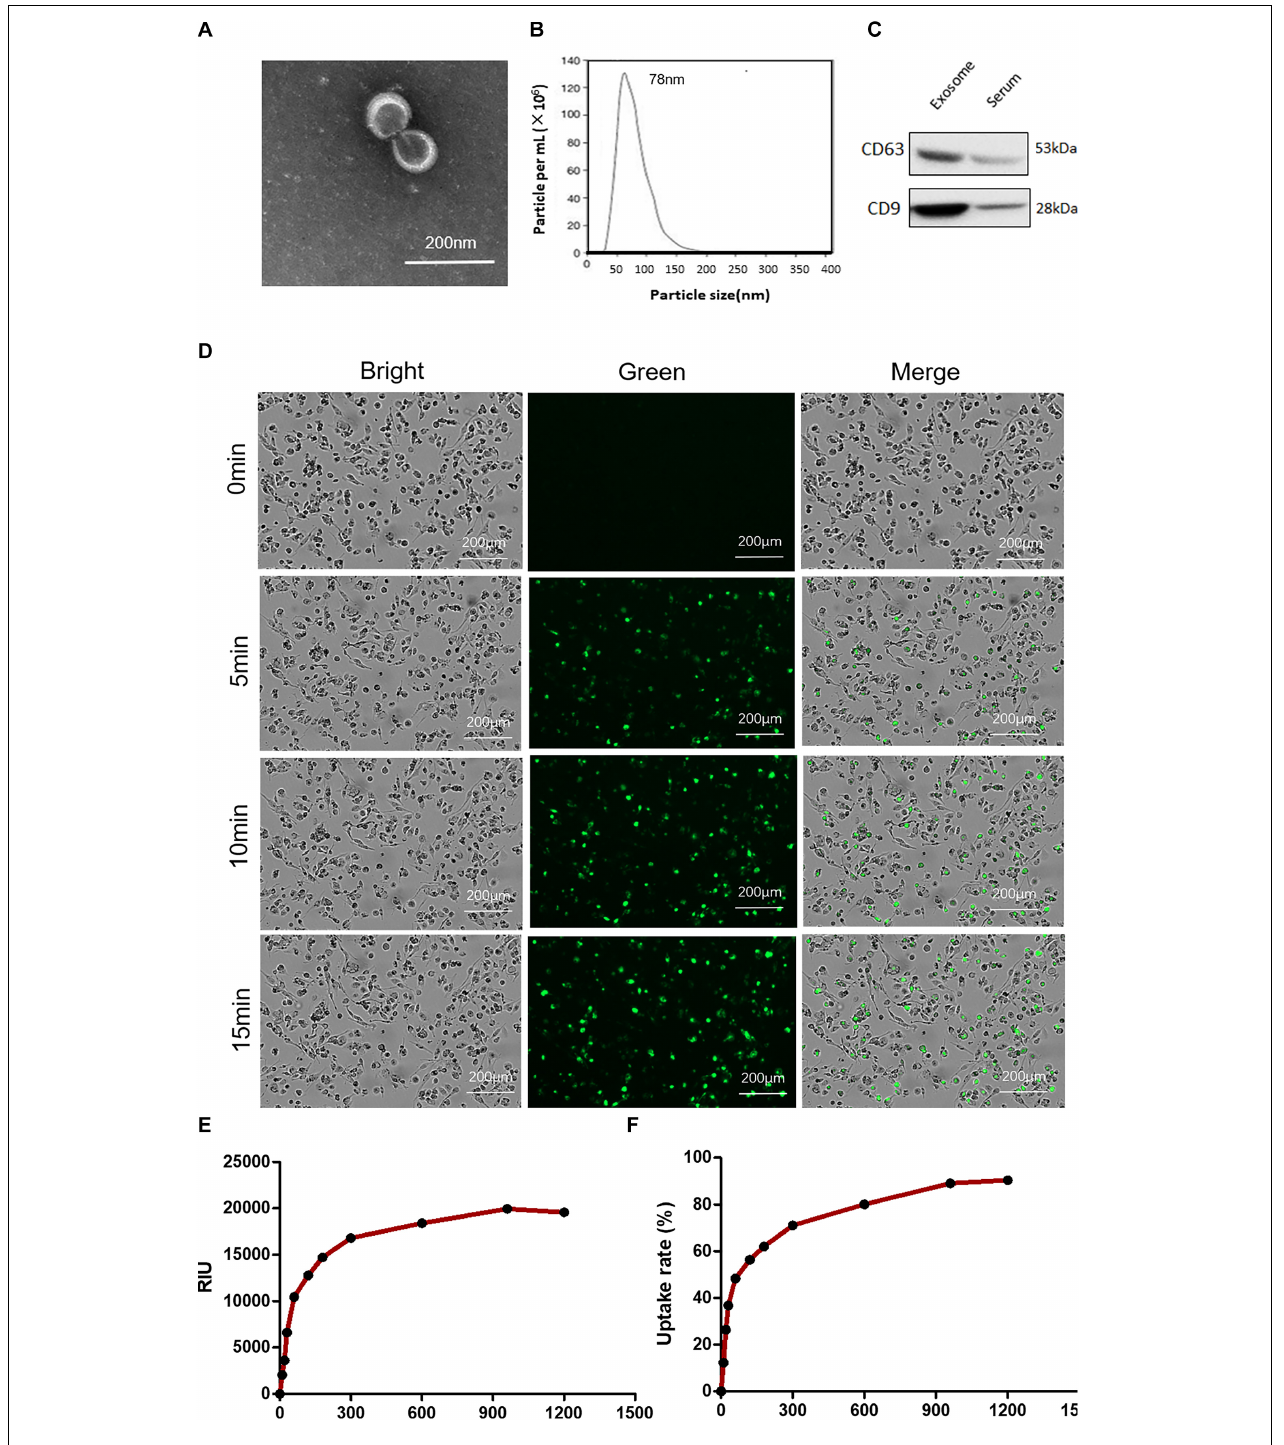
FIGURE 6 | Characterization of plasma exosomes and uptake of exosomes by macrophages. (A) Electron microscopy observation of whole-mounted exosomes purified from plasma. (B) Average overall size distribution of exosomes from plasma using nanoparticle tracking analysis. (C) The proteins from isolated exosomes were initially characterized on Western blot to assess the expression of CD63 and CD9. (D) Internalization of PKH67 (green)-labeled exosomes in THP1 cells induced by phorbol-12-myristate-13-acetate was captured by living cell imaging. Fluorescent cellular imaging was carried out using the green fluorescent protein channel for PKH67 fluorescence-labeled exosomes (green). Cell counts were detected with bright field. (E) The relative object integral fluorescence was measured over time with the uptake of exosomes. (F) The percentage of uptake rate was calculated with the software.